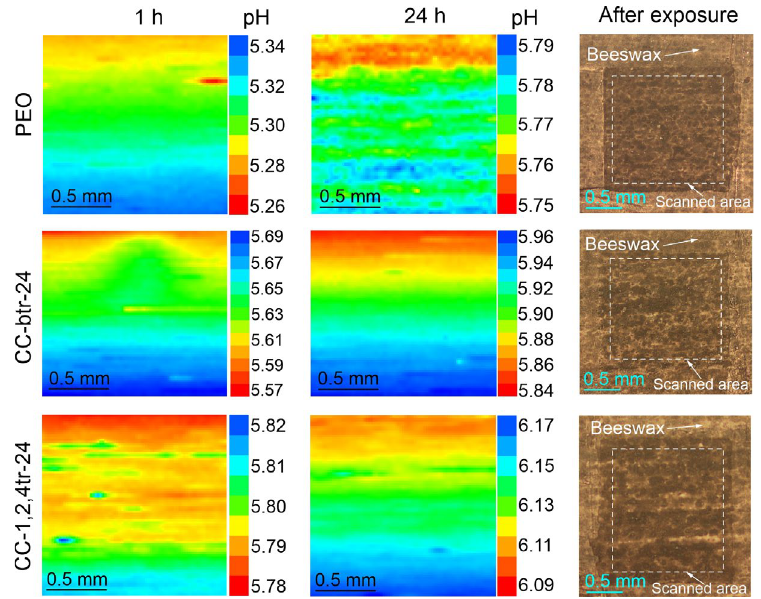
Figure 13. pH distribution (SIET) maps and optical images of scanned areas of samples with different types of coatings.